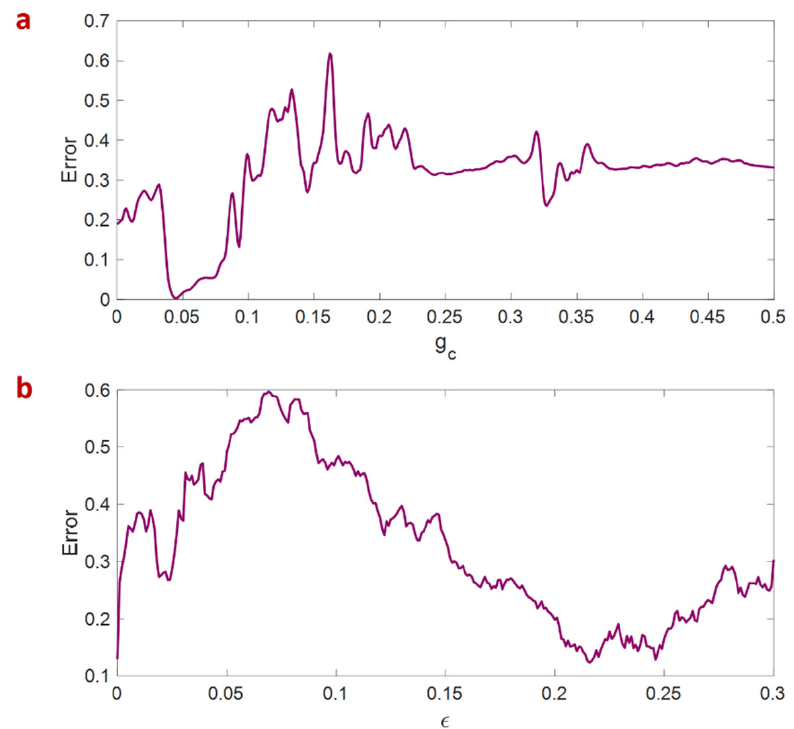
Figure 4. Synchronization error of the network of 100 memristive neuron maps connected through ( a ) chemical and ( b ) electrical synapses by the variation of coupling strengths. The network parame- ters are Θ s = − 40, β = 50, and v ∗ s = − 40. Complete synchronization can be observed in chemically coupled neurons for 0.0427 ≤ g c ≤